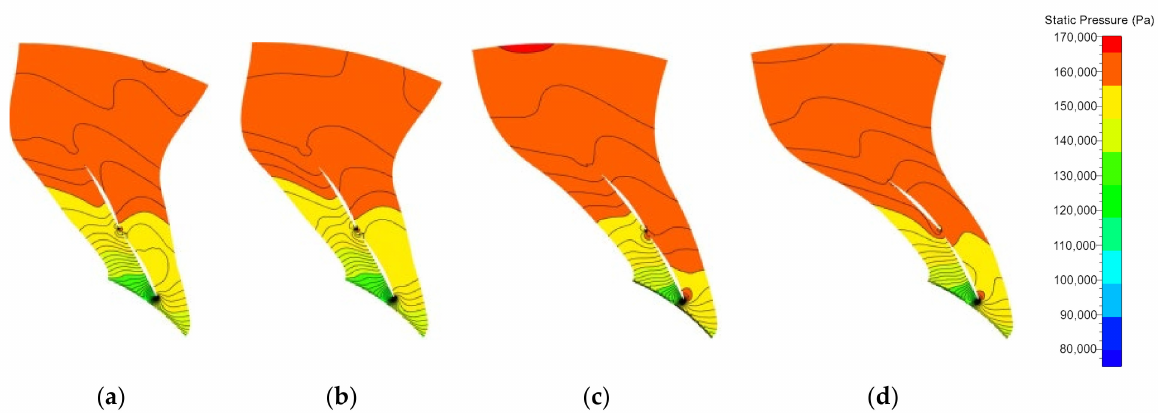
Figure 11. Static pressure distribution at 90% span in different cases. ( a ) 0 ◦ model; ( b ) 3 ◦ model; ( c ) 10 ◦ model; and ( d ) 18 ◦